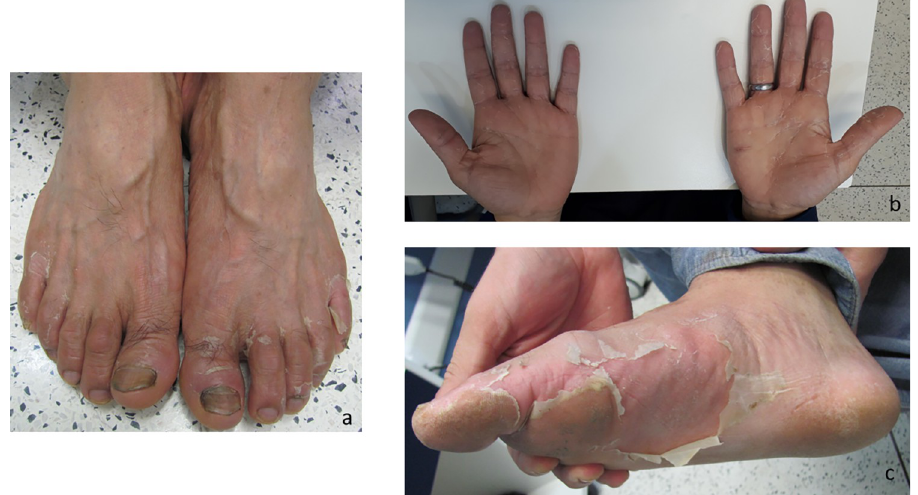
Fig 10. Patients bitten by a Loxosceles sp. spider and presenting desquamation on the feet and hands. (a) 17 days after the bite; (b) 24 days after the bite; (c) 36 days after the bite.